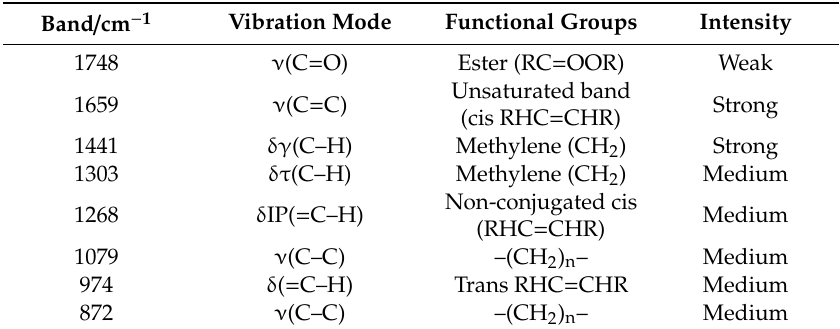
Table 1. Raman spectral distribution of the Atlantic salmon fat.